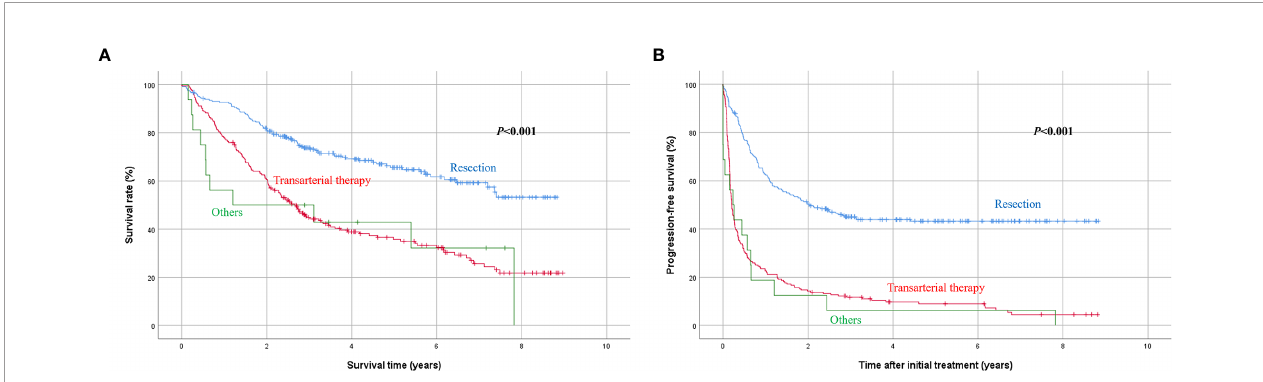
FIGURE 3 | Kaplan-Meier analysis of survival according to initial treatment modality. (A) Overall survival, (B) progression-free